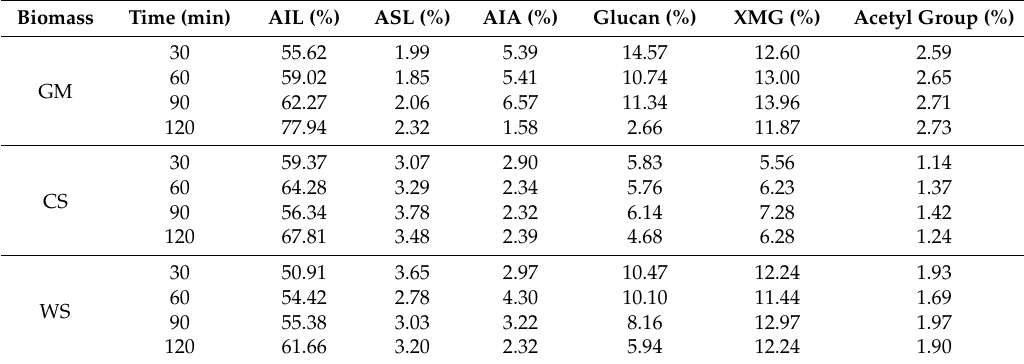
Table 5. Composition of lignin obtained from the black liquor depending on pretreatment time. ASL: acid-soluble lignin; AIA: acid-insoluble ash.